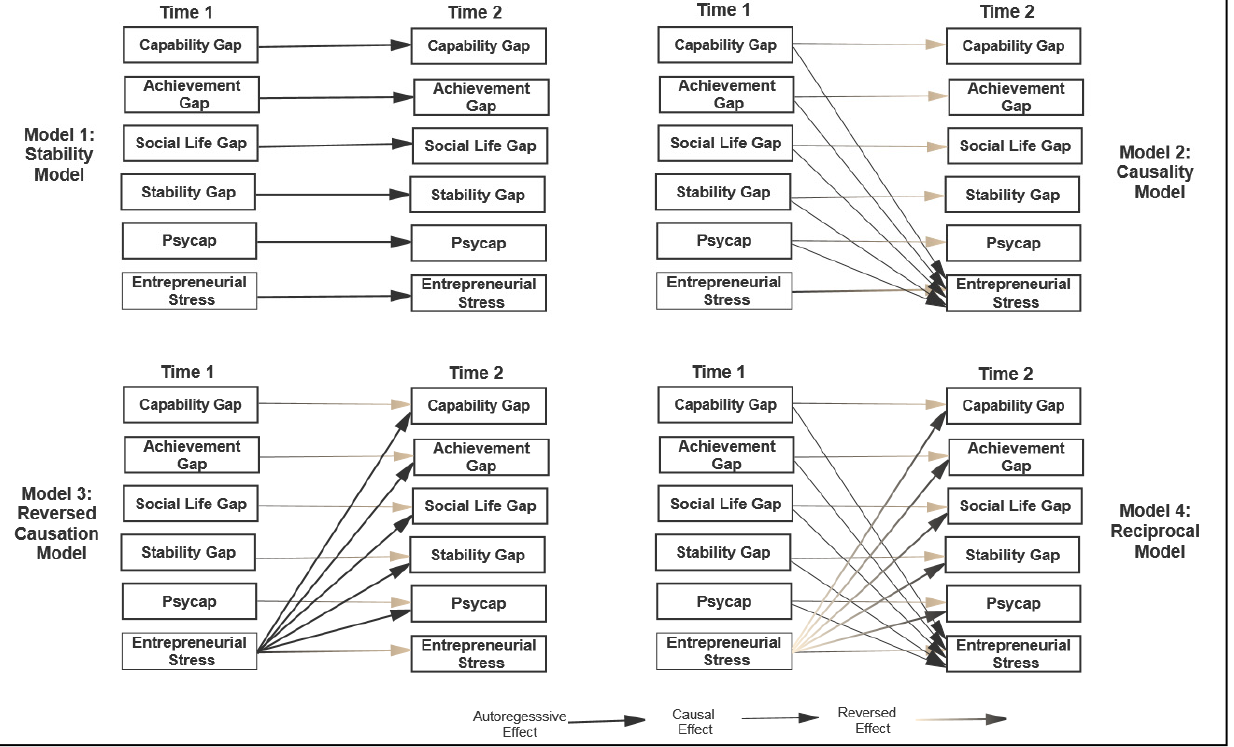
Table 2. Demographic profile of